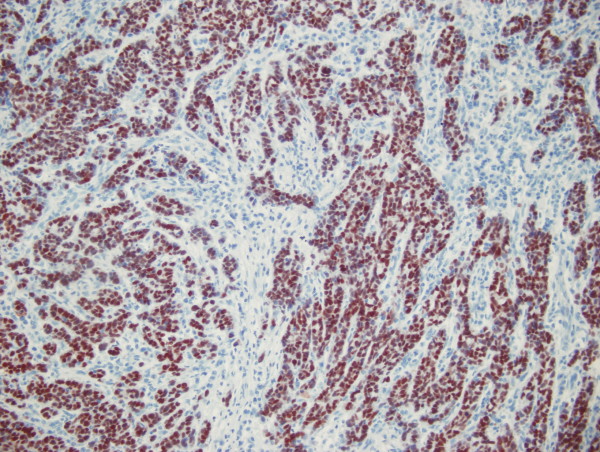
CDX2 expression in a high grade colorectal adenocarcinoma. Diffuse moderate to strong nuclear staining was seen. Original magnification × 200.